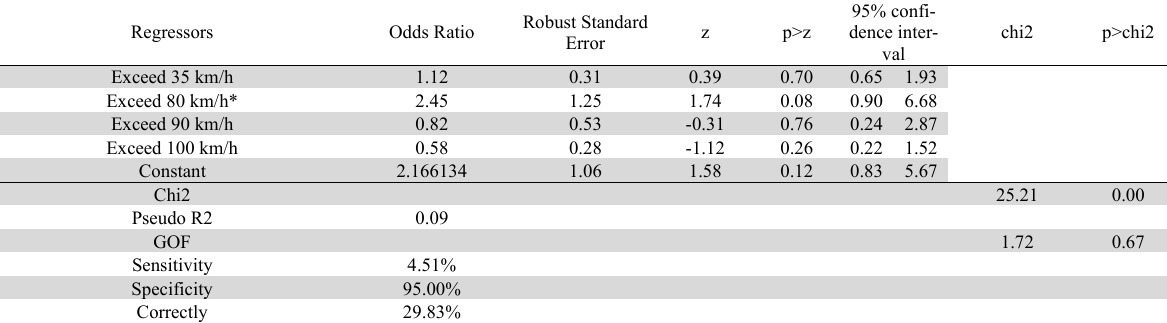
Logit regression for North Pan American highway